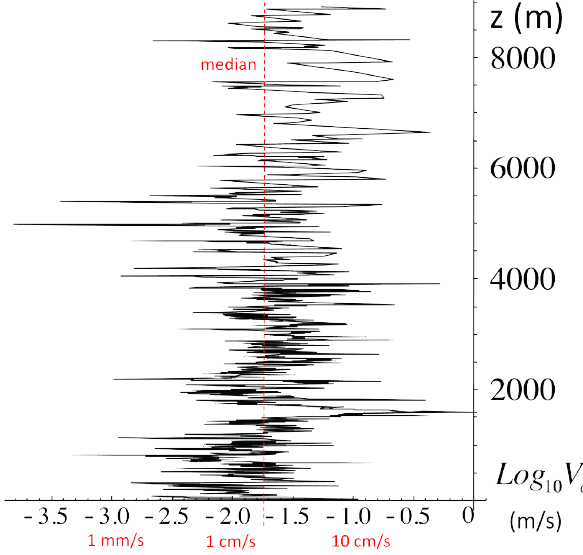
Fig. C3. This shows Log 10 V c where V c = (cid:0) δ c /δ 0 (cid:1) 1 / 2 is the critical speed, δ c is the critical value of the nondimensional smoothness parameter δ , and here we take δ c =0.01. For the application of the WKB method, we require V < V c . The median V c (1.9cms − 1 ) is shown by the dashed red